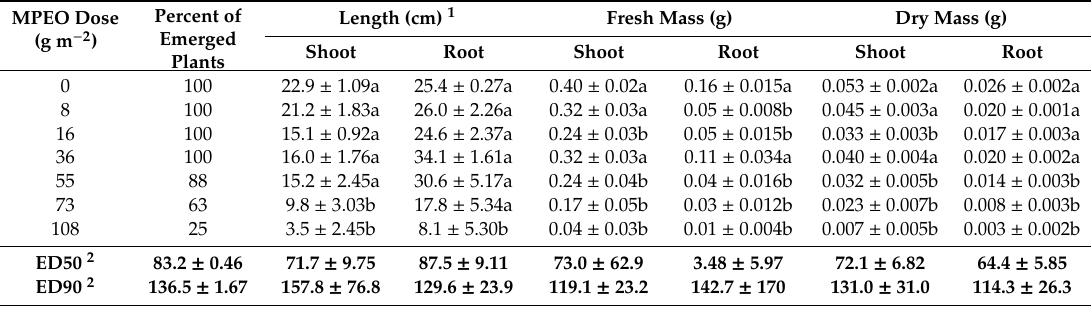
Table 2. Length of white mustard cv. ‘Zlata’ shoots and roots and their biomass at the growth stage of two pairs of true leaves (BBCH 14) after 8 weeks of growth in vermiculite amended with di ff erent doses of microencapsulated peppermint essential oil (MPEO with 9.6% (v / w) of peppermint EO content). Percent of MPEO Dose Length (cm) 1 Fresh Mass (g) Dry Mass (g) Emerged (g m − 2 ) Plants